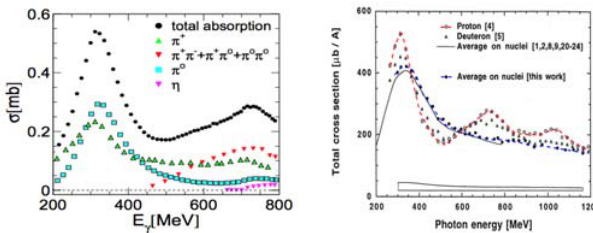
Figure 1: In the above left figure, much of the bump in the second resonance region is due to double pion production. The right figure above is also related to an old problem seen in total photoabsorption where the second resonance bump is completely suppressed for heavier nuclei